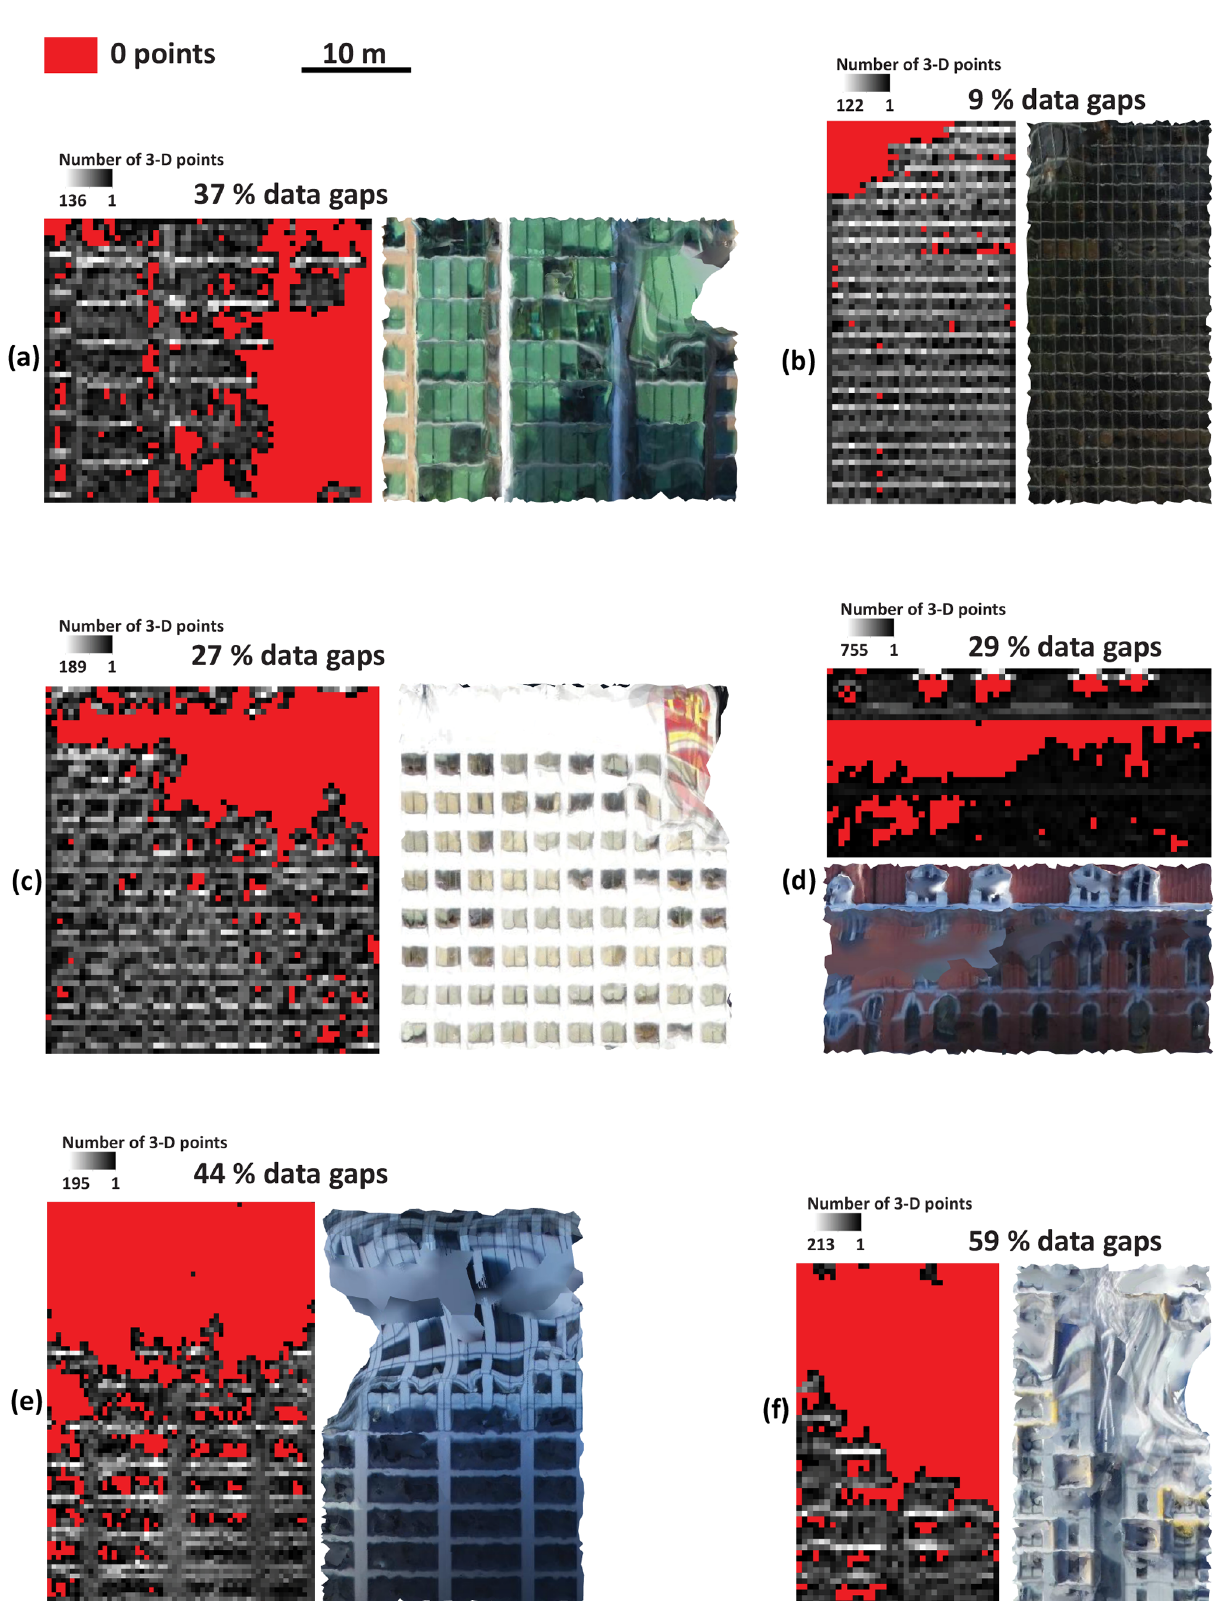
Figure 3. Sample building facades, each represented by a 0.50m 3-D point density raster and high-resolution mesh segmentation. Red cells within each raster represent data gaps (0 points per